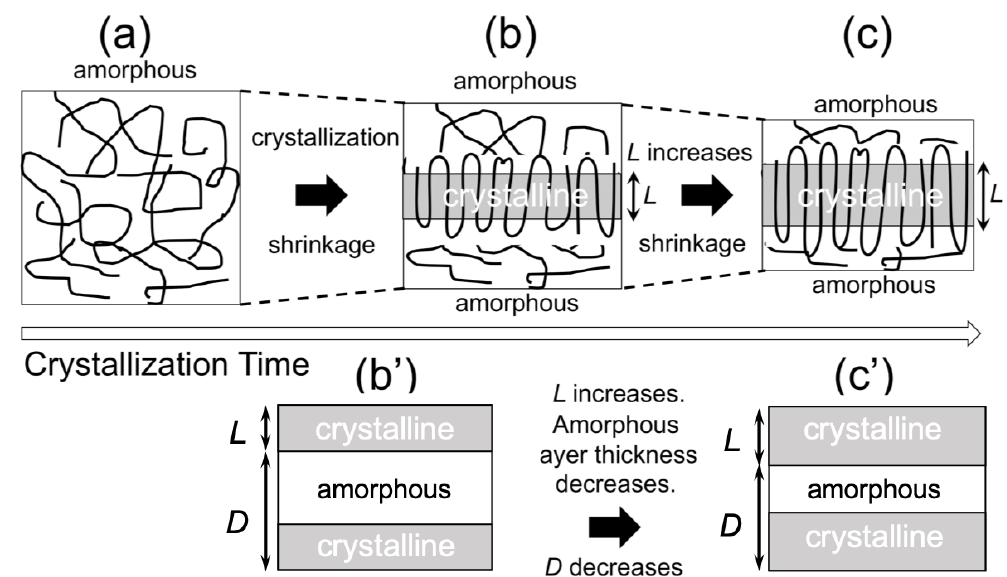
Figure 10. Schematic illustrations showing the change in the nanostructure upon crystallization of poly( L -lactic acid) (PLLA) ( a ) at the amorphous state before crystallization of the polymer melt and ( b ) in an early stage of crystallization. ( c ) Lamellar thickening in the subsequent stage of the crystallization. Note that the illustrations are focusing on the change in the long period ( D ) of the lamellar stacks. (b’) and (c’) correspond to the states of (b) and (c) , respectively. The illustrations of (b’) and (c’) are intended to explain the reason why D decreases as a function of time along the proceeding of crystallization where L increases with time.